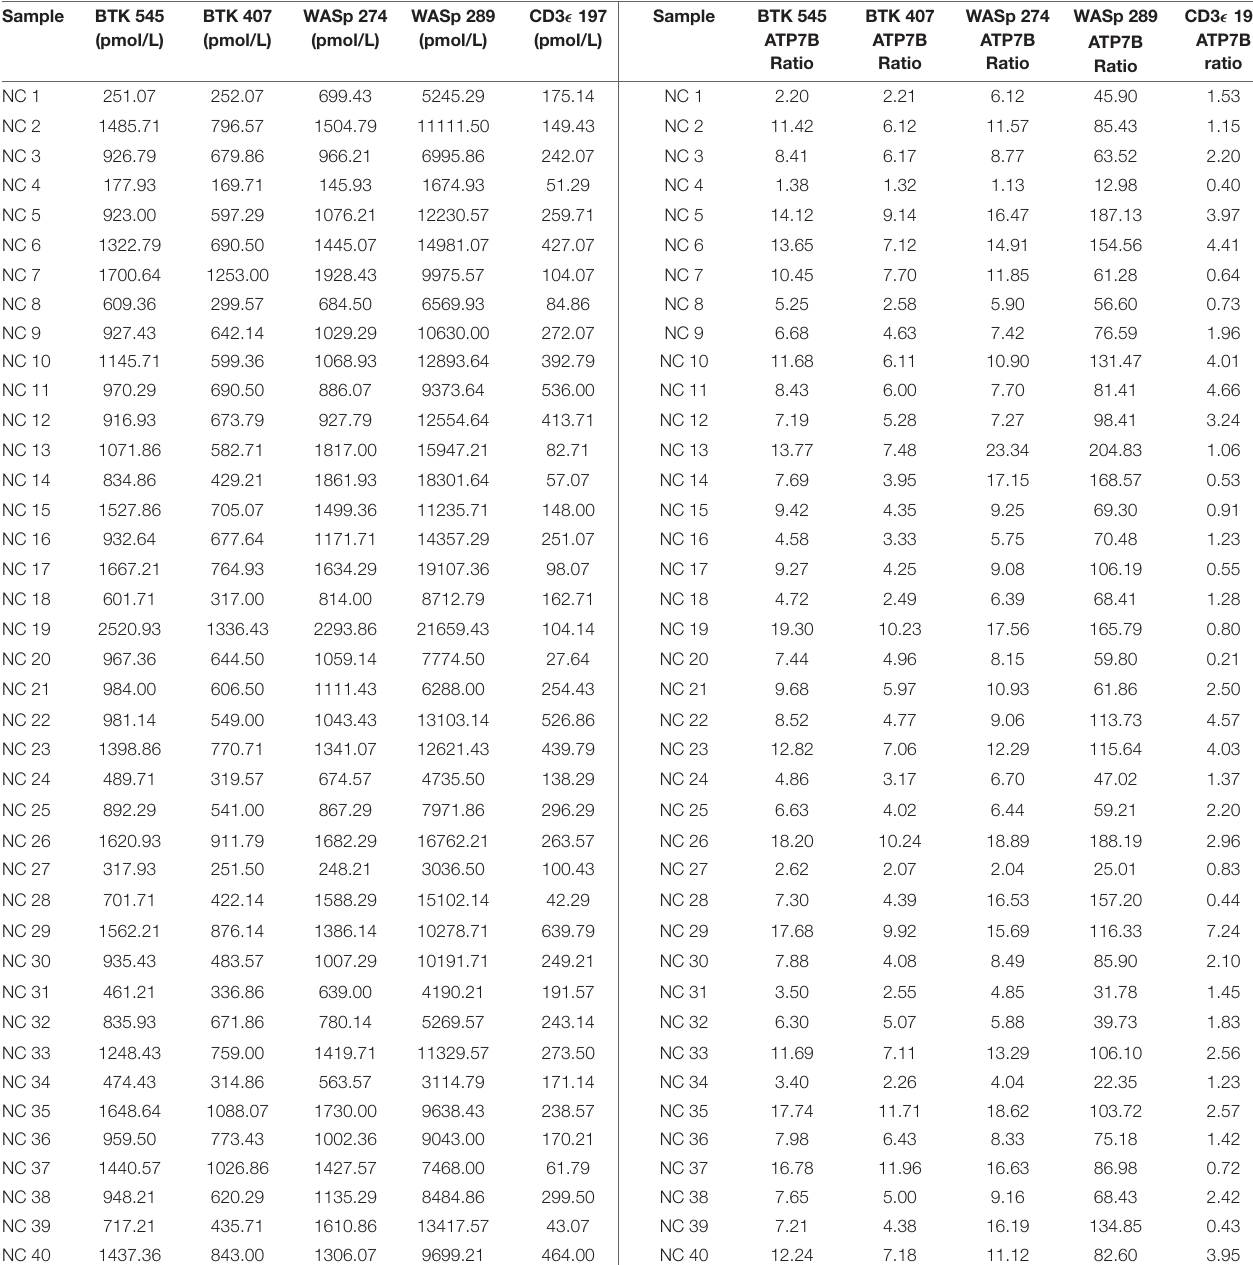
TABLE 6 | Quantification of signature peptides in normal controls from a blinded cohort study.